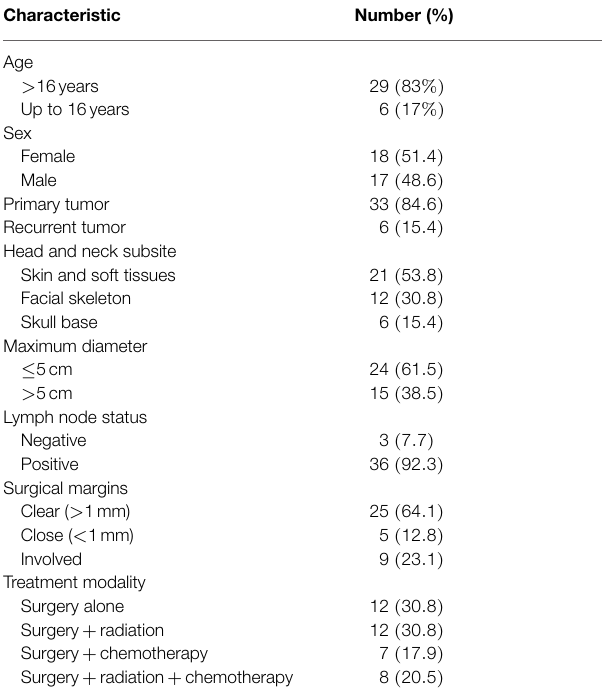
TABLE 1 | Patient demographics, tumor characteristics, and treatment modality .